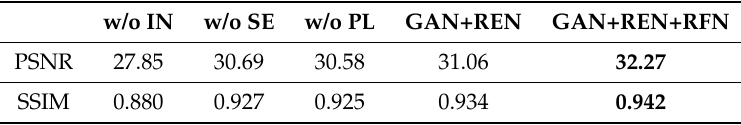
Table 1. Results of ablation experiments.